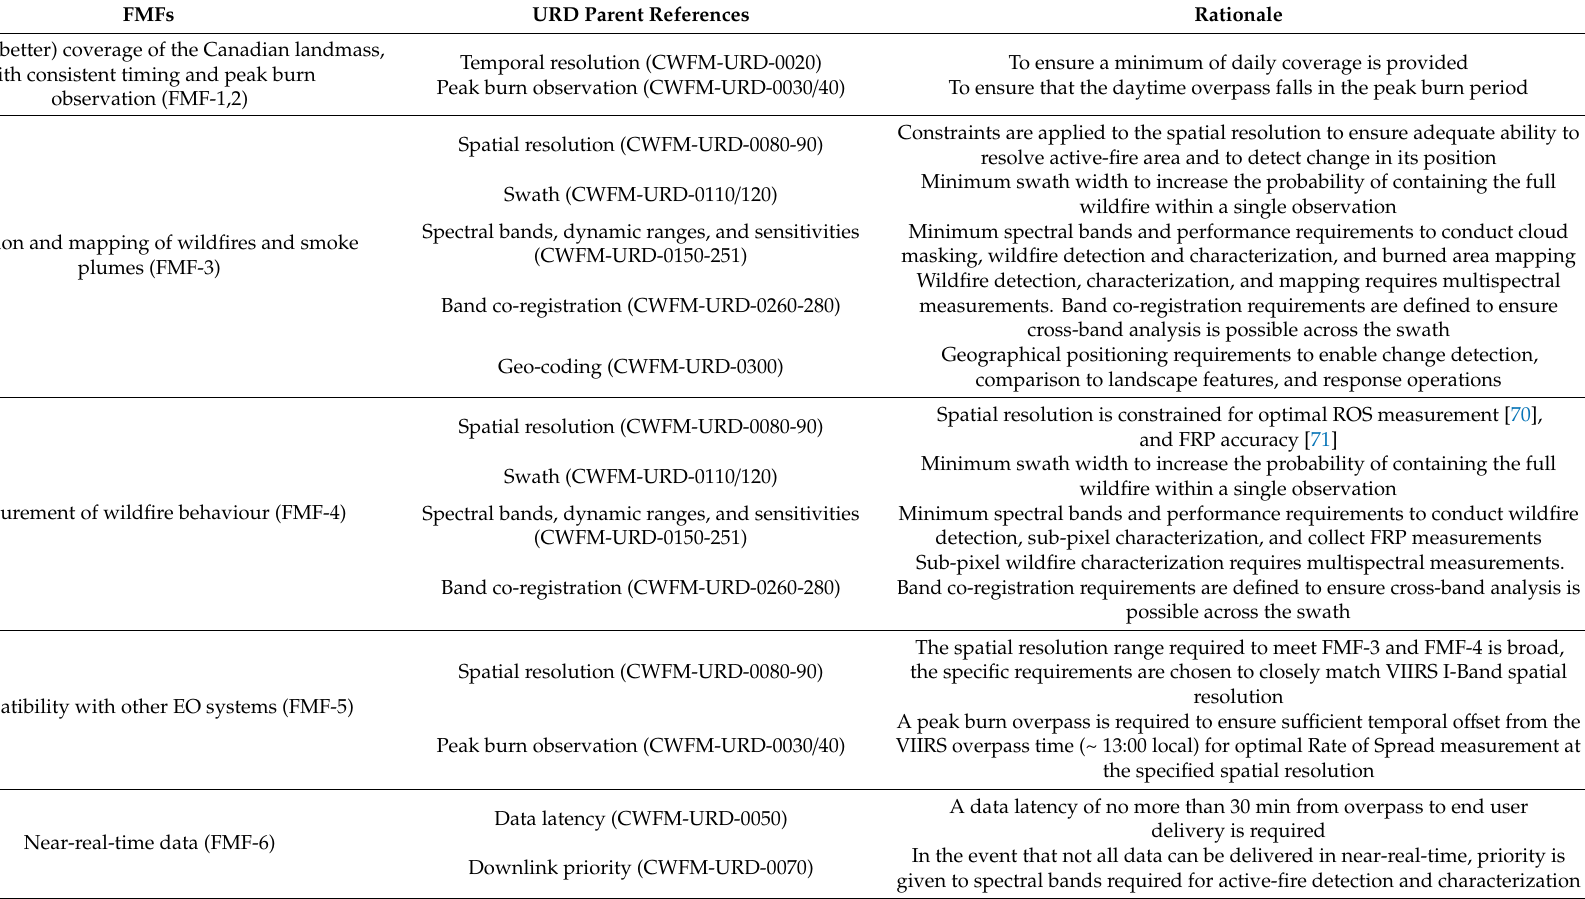
Table 3: Where URD refers to the User Requirements Document [49], and FRP refers to Fire Radiative Power (e.g.,